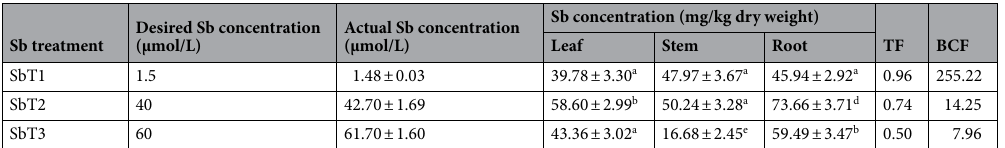
Table 1. Accumulation of Sb in different vegetative parts of T. natans. Data are presented as mean ± SD. Mean values with different superscripts letters within each column or row indicate that they were significantly different at a probability level of 0.05 according to ANOVA and post hoc test (Tukey HSD). Limit of detection (LOD) is 3 µg/L.